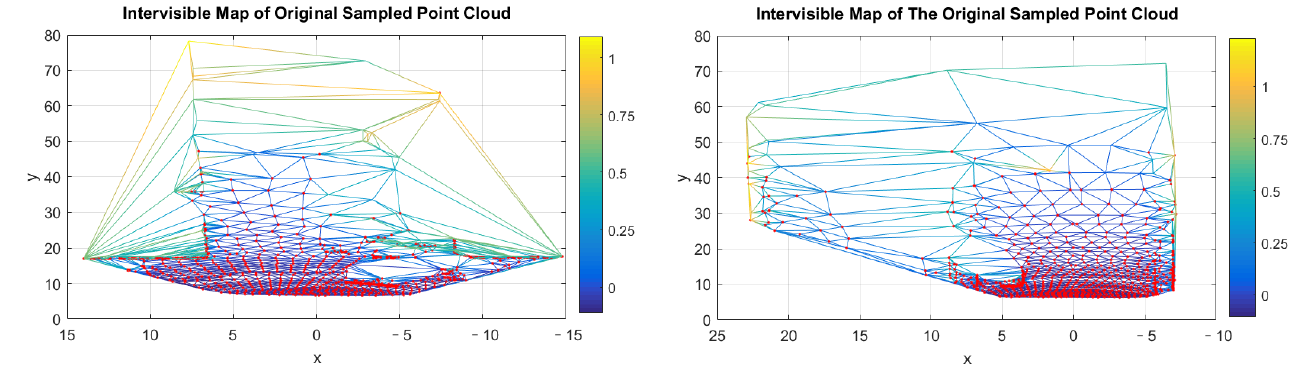
Figure 7. Intervisibility mapping on FOV estimation.